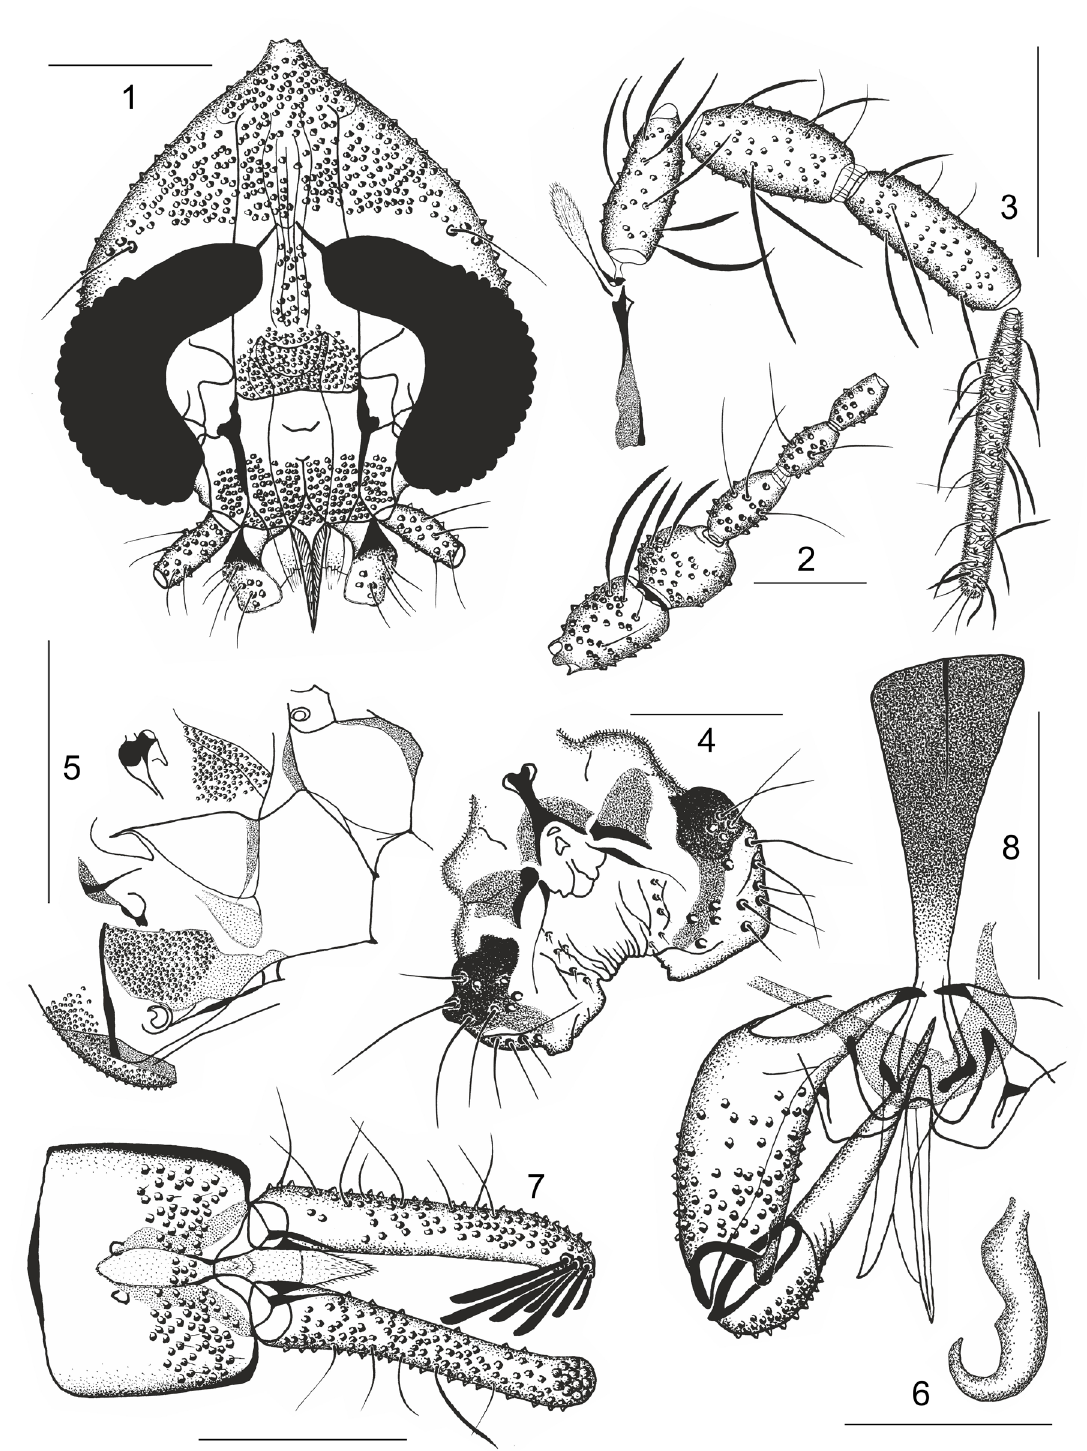
Figs 1–8. Pneumia fuehzulii sp. nov., ♂. 1 . Head, frontal view. 2 . Scape, pedicel and basal flagellomeres. 3 . Maxilla and palpus maxillaris. 4 . Terminal lobes of labium, dorsal view. 5 . Thoracic sclerites, lateral view. 6 . Tarsal claw of P , lateral view. 7 . Epandrium and epandrial appendages, dorsal view. 8 . Aedeagal 1 complex, gonopod and hypandrium, dorsal view. Scale bars: 1, 3, 7–8 = 0.2 mm; 2, 4 = 0.1 mm; 5 = 0.5 mm; 6 = 0.03